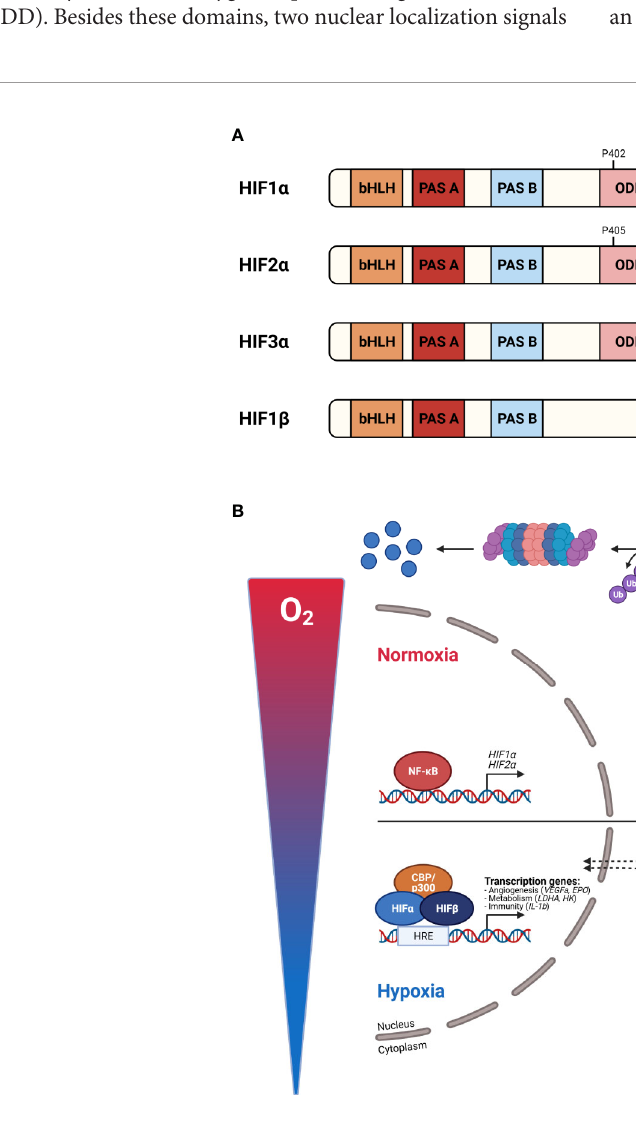
FIGURE 3 | Protein structure of hypoxia inducible factors (HIFs) (A) and their activity under normoxic and hypoxic conditions (B) . (A) HIF proteins are basic helix- loop-helix Per-Arnt-Sim (bHLH-PAS) transcription factors build up by an a -subunit and b -subunit. HIF1 a consist of a bHLH and PAS domain, necessary for DNA binding and homodimerization, respectively. Further, an oxygen-dependent domain (ODDD) and two transactivation domains (N-TAD and C-TAD) are present. The stability and target gene speci fi city are determined by the N-TAD which overlaps with the ODDD. The C-TAD regulates the interaction with co-activators thereby activating gene transcription. HIF1 a and HIF2 a differ within their transactivation domain, while HIF3 a is known as the dominant-negative regulator. Due to the absence of the ODDD, HIF1 b is constitutively expressed. (B) In normoxia, prolyl hydroxylases (PHDs) hydroxylate proline (P) residues in the ODDD leading to the binding of the von Hippel-Lindau protein (pVHL) followed by ubiquitination and degradation by the 26S proteasome. The factor inhibiting HIF1 (FIH) hydroxylates asparagine (N) residues in the C-TAD, preventing the interaction of the C-TAD with co-activators thereby inhibiting gene transcription. When oxygen levels decrease, PHDs are inactivated, the HIF a subunits are stabilized, dimerize with HIF b and translocate to the nucleus. After CBP/p300 are recruited, gene transcription is induced by binding to hypoxia-responsive elements (HREs). Figures created with